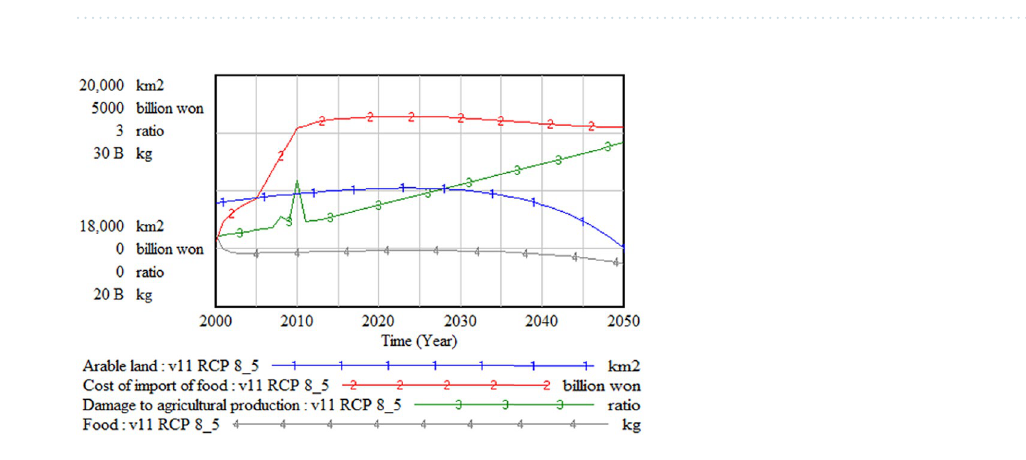
Figure 9. Comparison of industrial output damage between urban and rural areas.